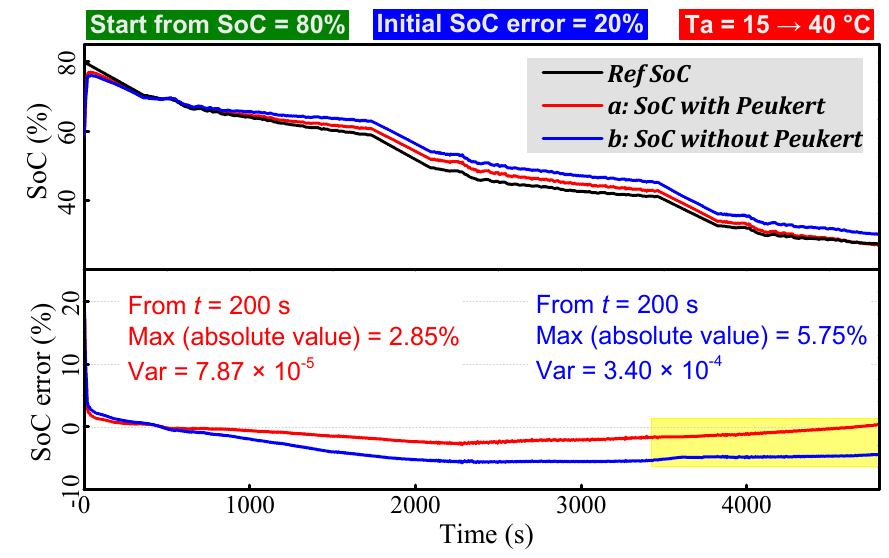
Figure 11. SoC estimation results with and without Peukert adaption, with 20% initial error under a varying temperature from 15 °C to 40 °C.